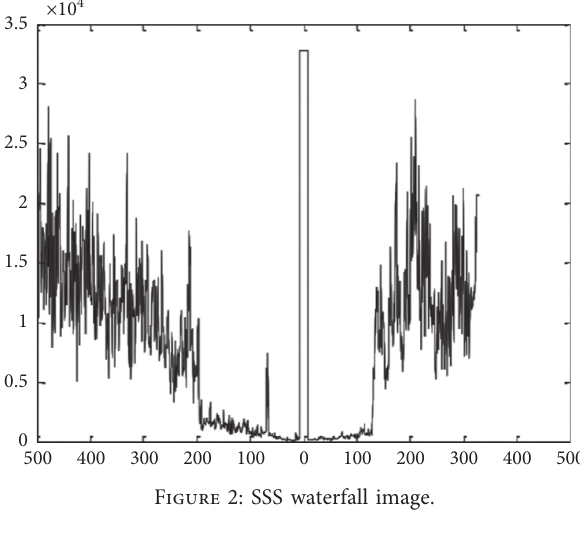
Figure 2: SSS waterfall image.